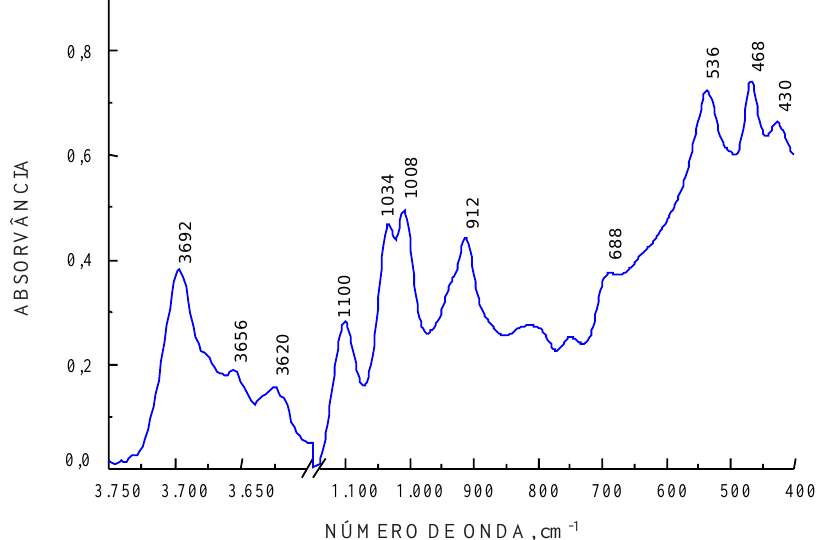
Figura 5. Espectro da diferença de absorvância no infravermelho antes e depois da purificação dos ácidos húmicos, extraídos do horizonte A de um Latossolo Vermelho-Amarelo, evidenciando os picos referentes à